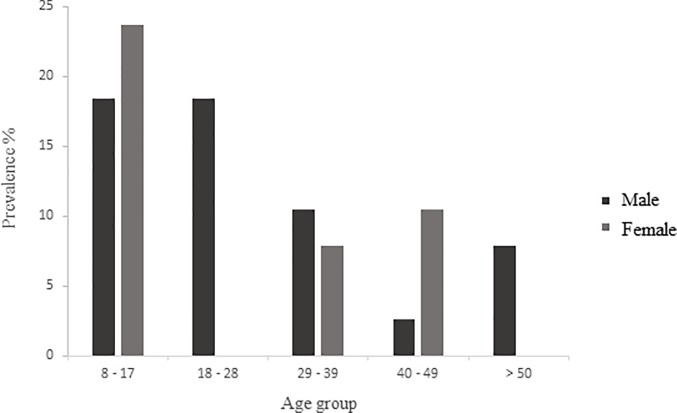
Age group distribution of S. mansoni infection, 2014.